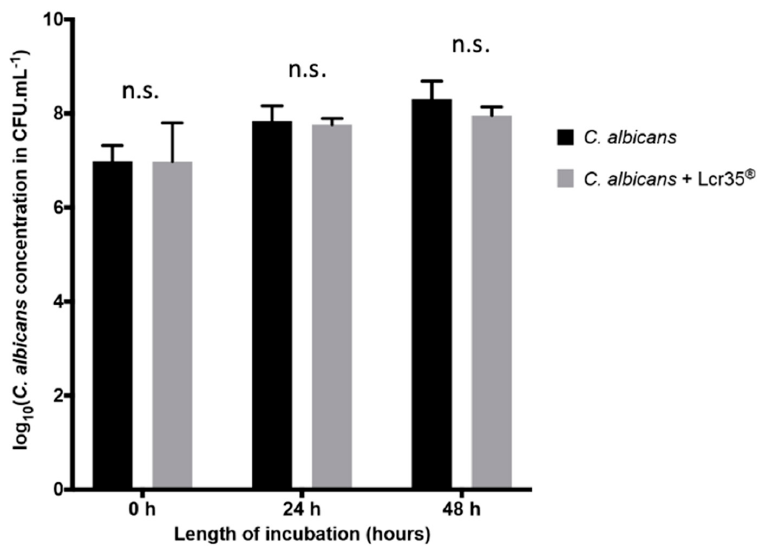
Figure 1. Evolution of the concentration of C. albicans in the presence or not of Lcr35 ® onto Caco-2 cells monolayers. Results are expressed as log 10 CFU/mL of yeasts alone (controls) and in co-incubation with Lcr35 ® (mean ± standard deviation). Comparison between conditions with and without Lcr35 ® was performed using a two-way ANOVA followed by a Fisher’s Least Significant Difference (LSD) post hoc test (n.s.: not significant).